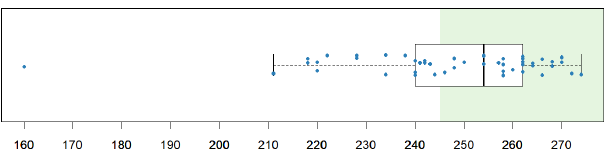
Figure 4. Boxplot of the game score for each study participant. Scores ≥ 245 points are considered good (indicated by the green background). The box represents the 25th and 75th percentile; the line is the median; the whiskers extend to 1.5 times the interquartile range. The individual scores (blue dots) are jittered to improve the visibility of all